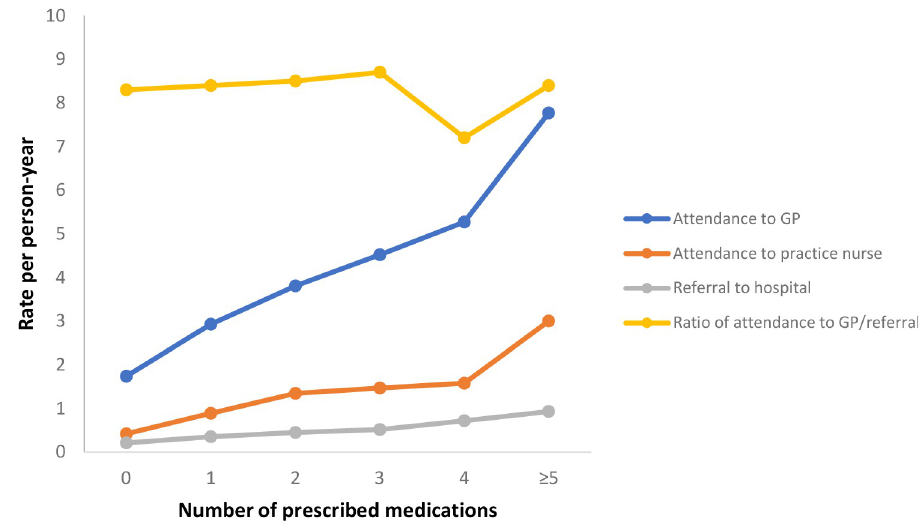
Fig 3. Attendances and referrals by number of prescribed